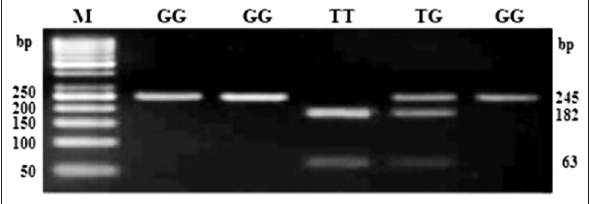
Figure-1: Polymerase chain reaction-restriction fragment length